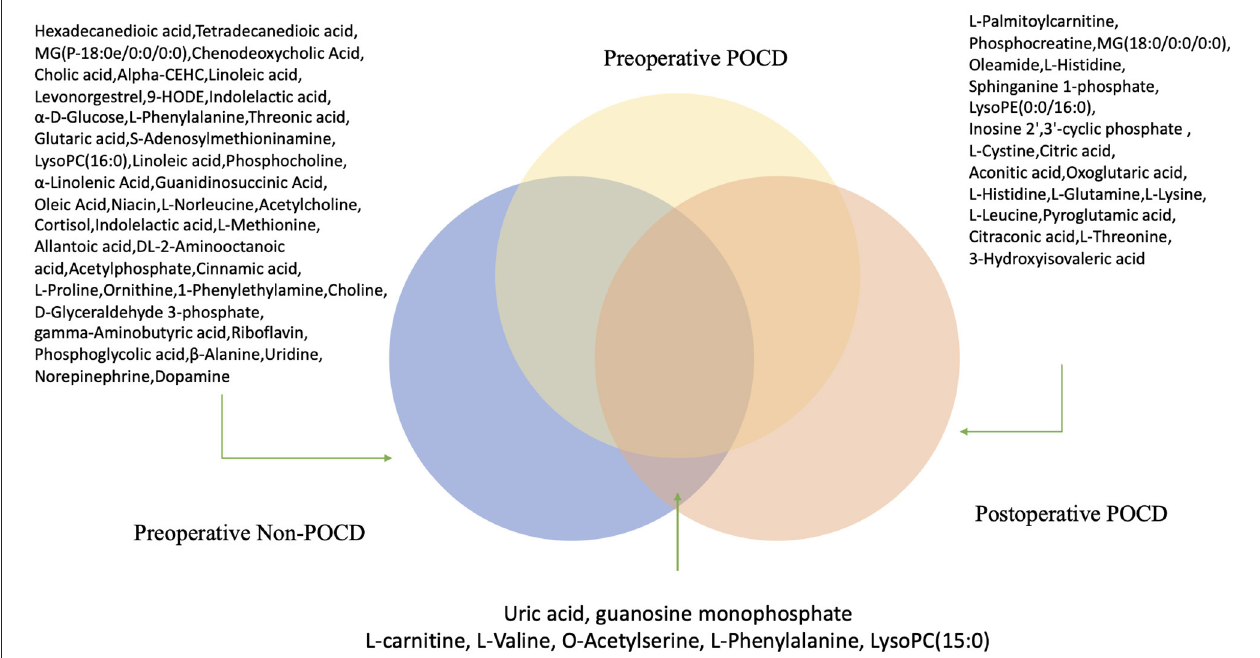
FIGURE 6 | Hypothetical figure for significant differential metabolites appeared in both preoperative comparisons of POCD and Non-POCD groups, and pre- and post-operative comparison of the POCD